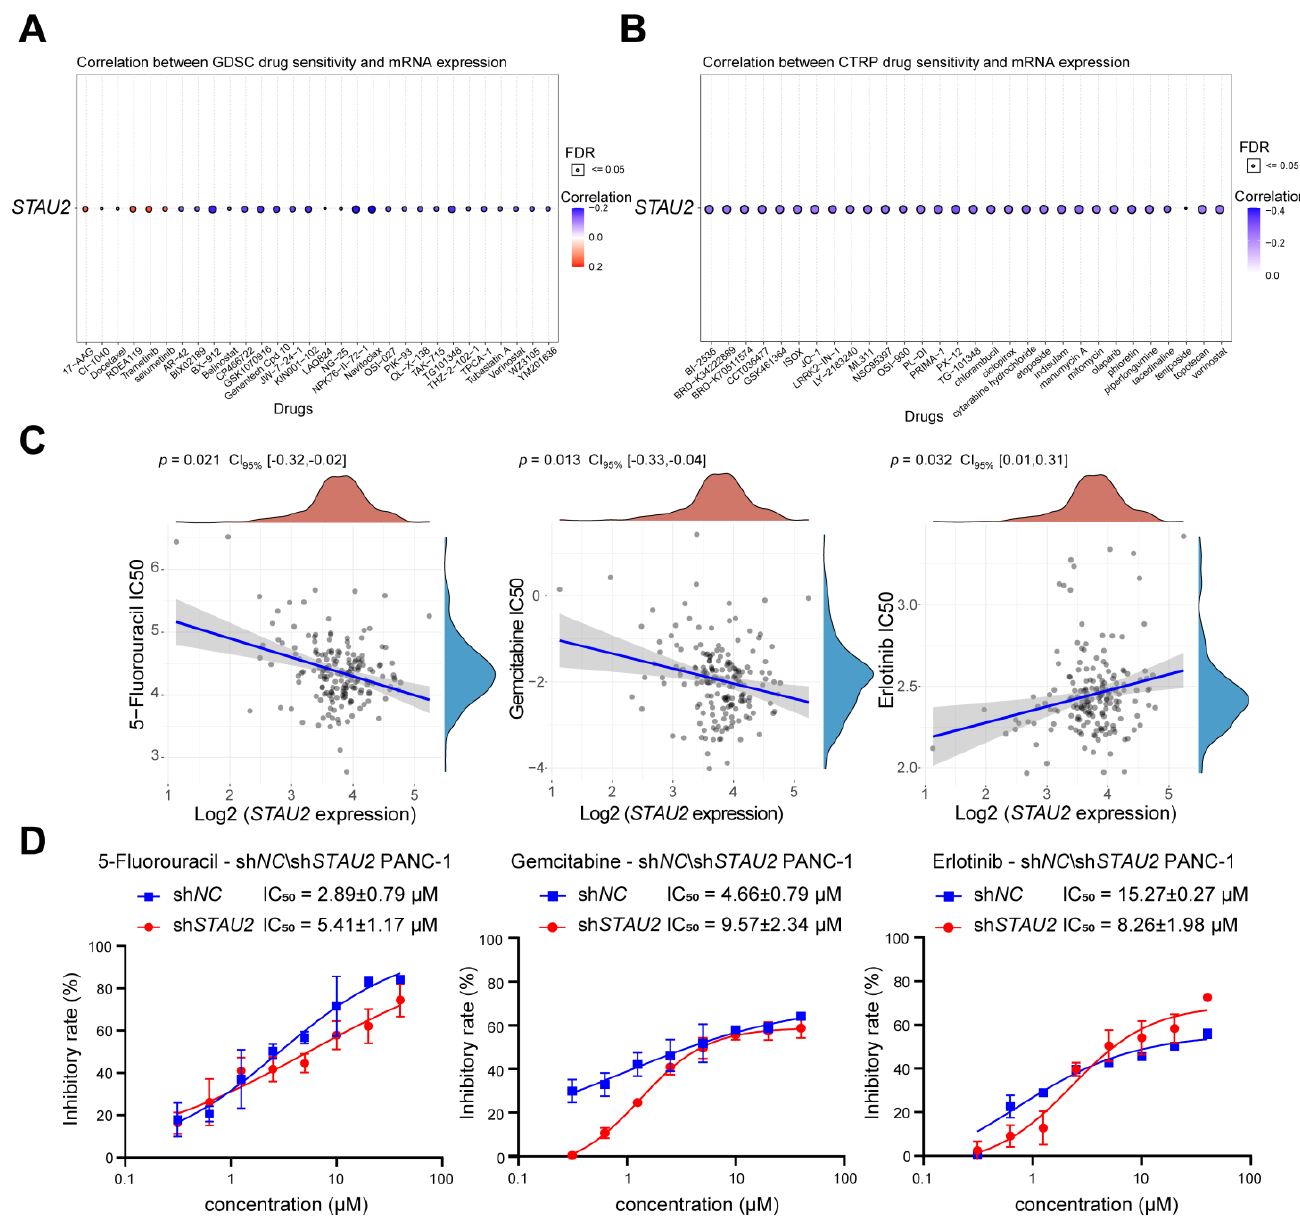
Figure 10. Prediction of the relationship between STAU2 expression and drug sensitivity. ( A ) Drug sensitivity of STAU2 from GDSC. Dot plots show correlations between gene expression and GDSC connectivity. ( B ) Drug sensitivity of STAU2 from CTRP. Scatter plot showing the correlation between gene expression and CTRP binding. The size of the dots represents the FDR value, and the color of the dots represents the correlation, with red being positively correlated and blue being negatively correlated. ( C ) The correlation between IC 50 score of first-line drugs for pancreatic adenocar- cinoma and STAU2 gene expression was analyzed by Spearman correlation. ( D ) IC 50 of sh STAU2 PANC-1 cell and sh NC PANC-1 cell treated by 5-Fluorouracil, Gemcitabine, and Erlotinib. Data were generated from three independent trials. Error bar, mean ± SD, n = 3.